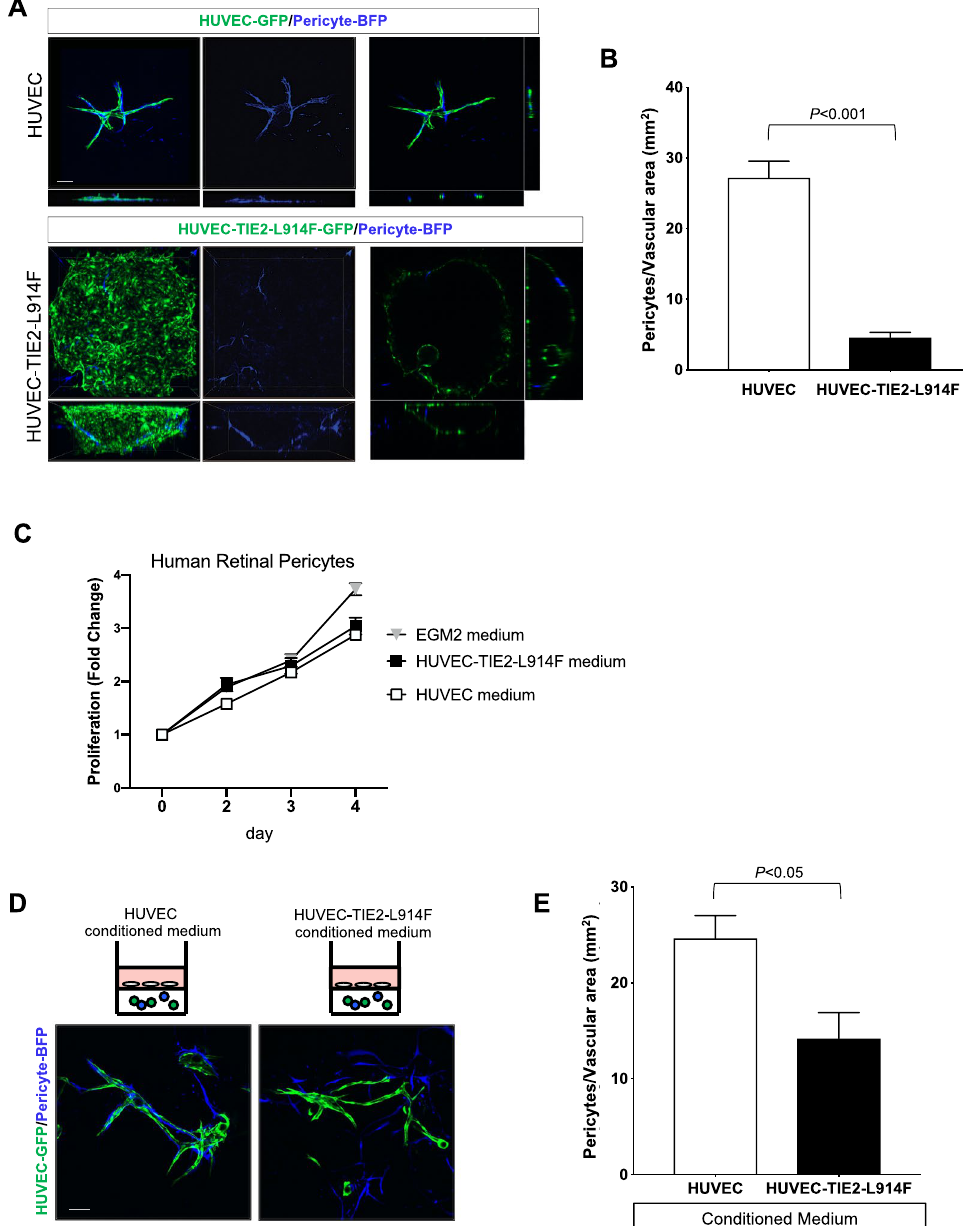
Figure 5. HUVEC-TIE2-L914F form channels with scarce recruitment/contact with pericytes, akin to patients’ VM lesions. ( A) Z-stack images (max projection) (left panels) of fibrin gels containing GFP-labeled -HUVEC or - HUVEC-TIE2-L914F and BFP (blue fluorescent protein)-labeled human retinal pericytes (10:1 ratio), single slice image taken in the center of the z-stack (right panels) at day 10. Scale bar: 200 μ m. ( B) Quantification of pericytes located on the surface of vascular channels (n = 4–5 independent vascular fields were analyzed). ( C) Proliferation rates of human retinal pericytes cultured with conditioned medium from HUVEC, or HUVEC-TIE2-L914F, or EGM2 as a normal control culturing condition (n = 3 independent experiments). ( D) Z-stack images (max projection) of fibrin gels containing GFP-labeled-HUVEC and BFP-pericytes treated with conditioned medium from HUVEC or HUVEC-TIE2-L914F. Scale bar: 200 μ m. ( E) Quantification of pericytes located on the surface of the HUVEC-derived vascular channels (n = 5 independent vascular fields were